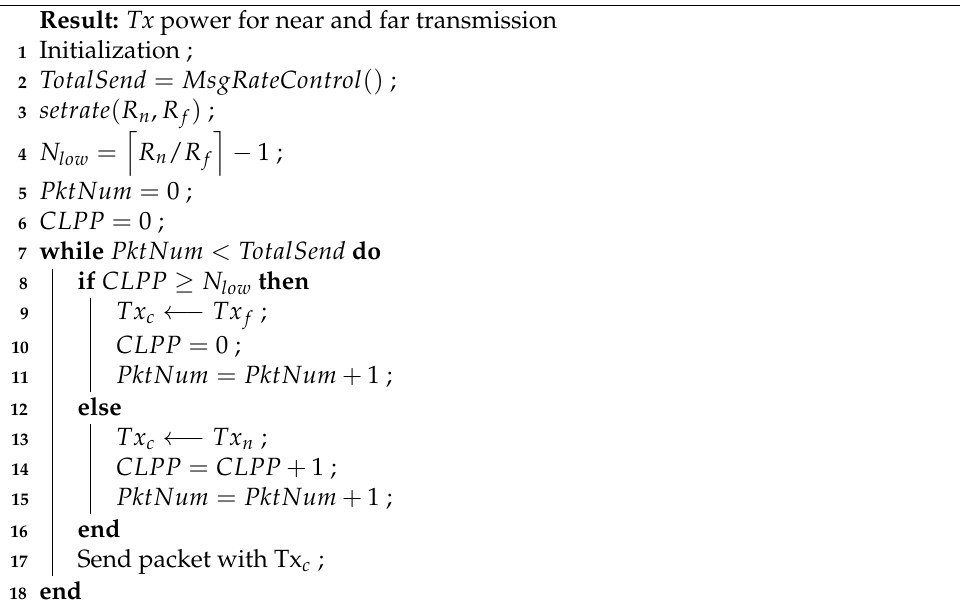
Figure 1. Desired transmission pattern. Algorithm 2: A hybrid approach combined with random rate control